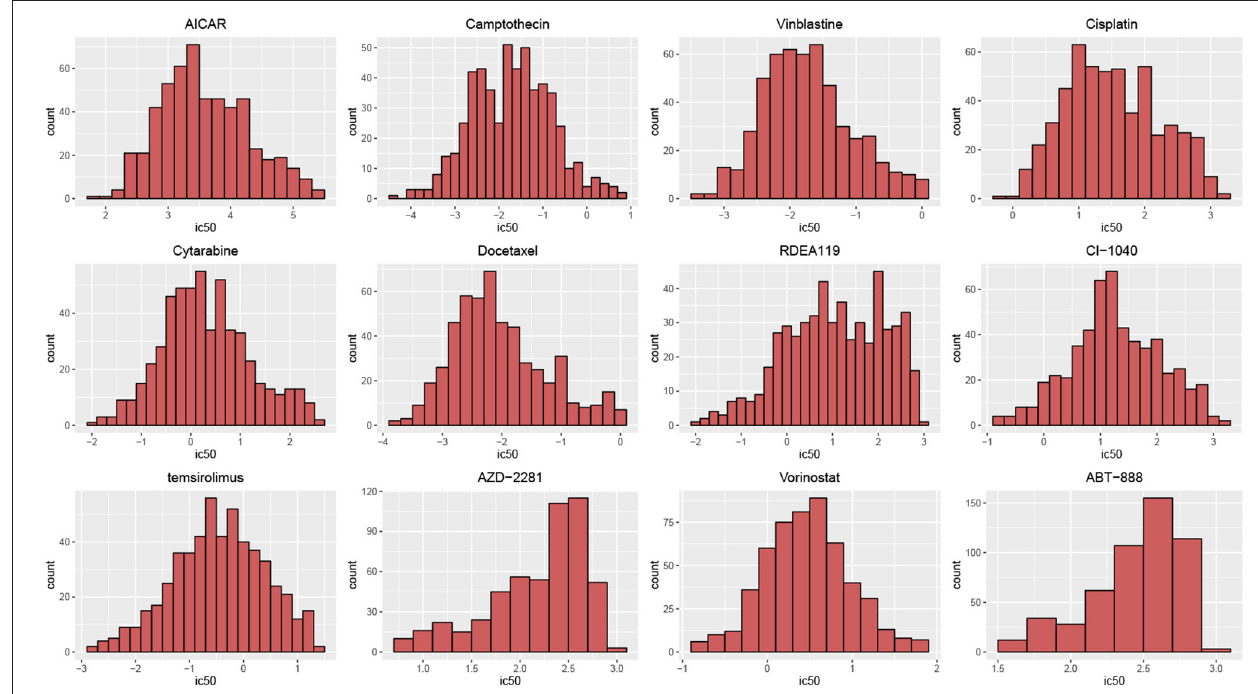
FIGURE 2 | Histograms of drug responses for 12 drugs in GDSC. The distributions of drug responses were different for various drugs.